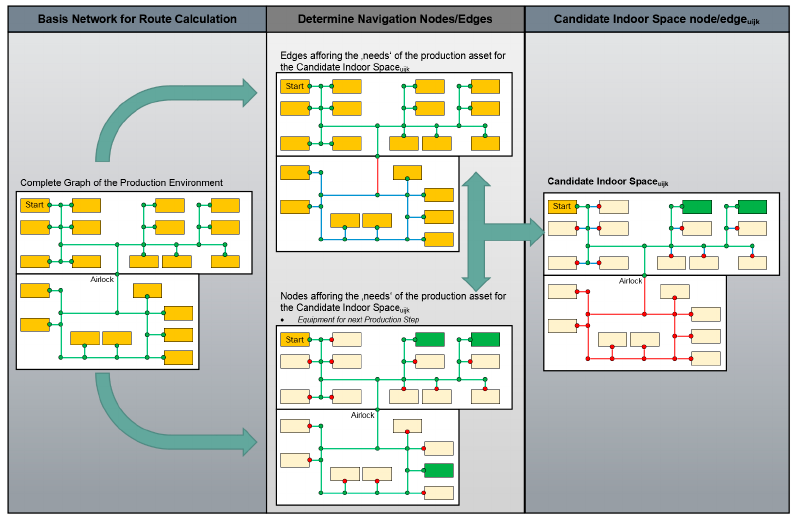
Figure 4. Intermediate results of the implemented approach from the complete graph as starting point to the candidate indoor space node/edge uijk including affordances.